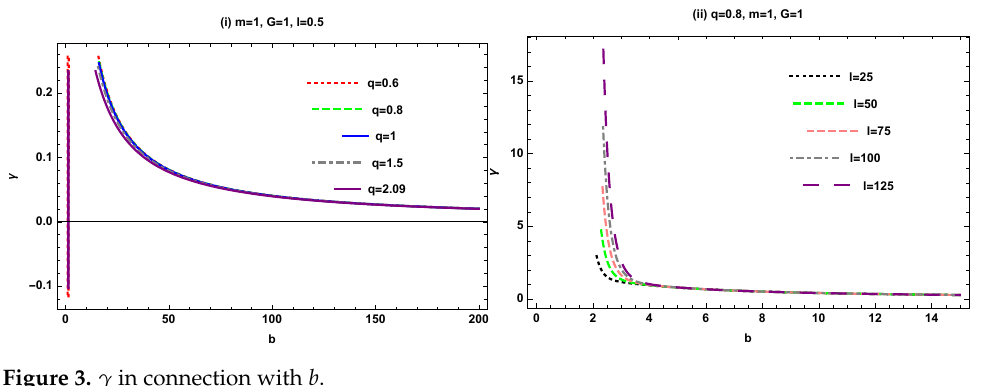
Figure 1: γ in connection with b . Figure 3. γ in connection with b .